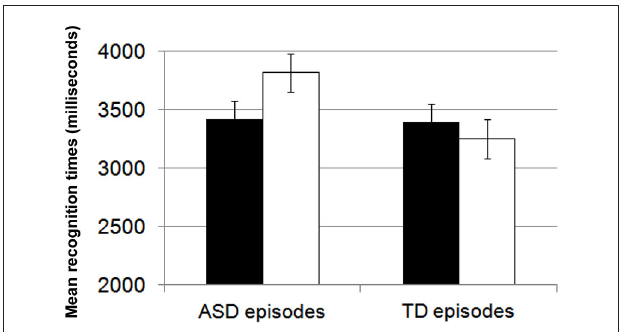
FIGURE 2 | Comparison of consistent and inconsistent episodes in individuals with ASD . Black bar shows consistent episodes. White bar shows inconsistent episodes. Individuals with ASD retrieved ASD-consistent episodes faster than they retrieved ASD-inconsistent